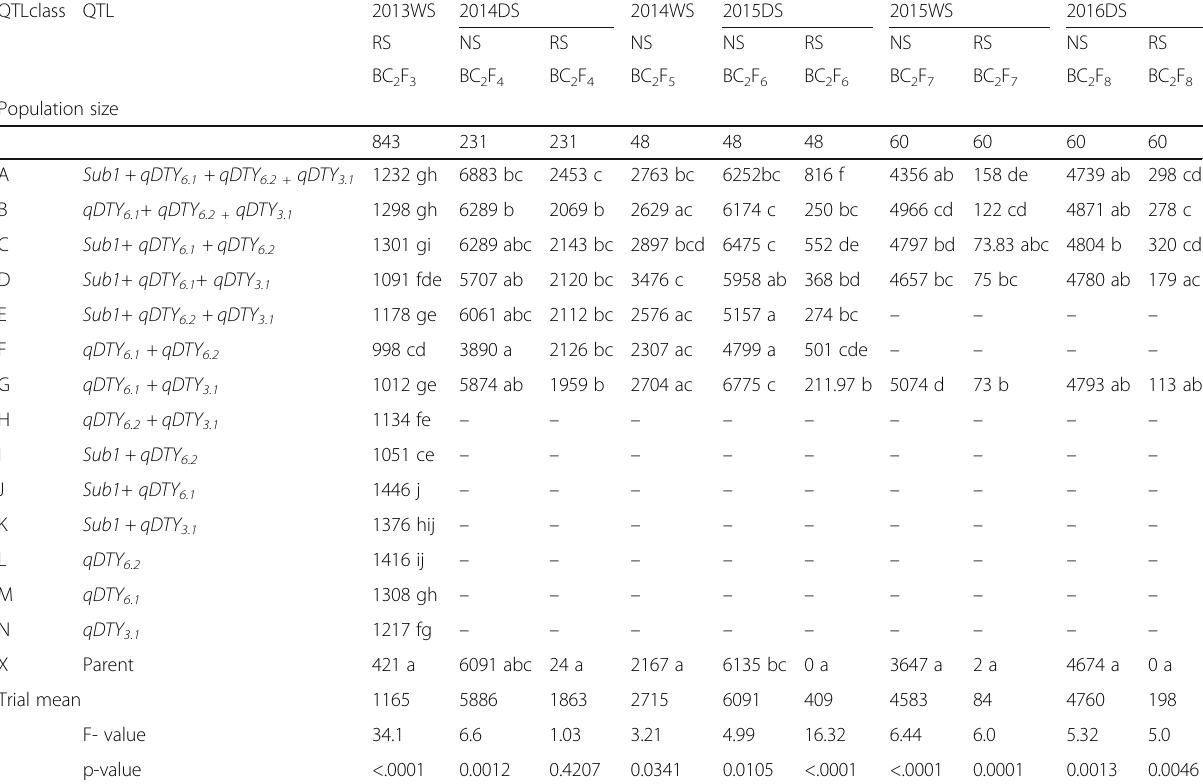
Table 4 Mean comparison of QTL classes of grain yield (kg ha − 1 ) across BC 2 F 3 to BC 2 F 8 generations under reproductive-stage drought stress and irrigated non-stress control conditions in TDK-Sub1 background at IRRI, Philippines